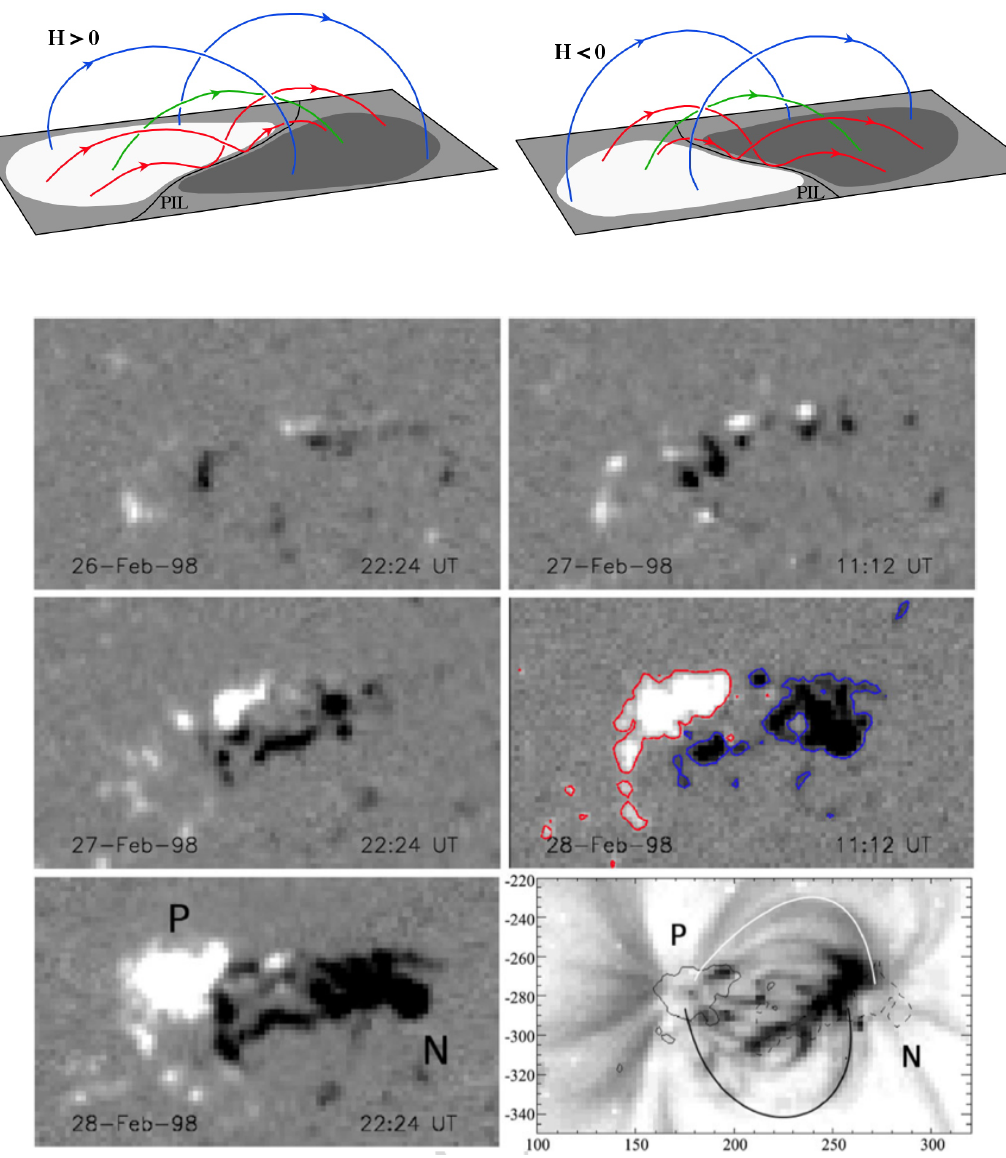
Figure 9: Upper panels: Sketches of magnetic “tongue” patterns in longitudinal magnetograms with (left) positive and (right) negative global twist in the emerging flux rope, which develop due to the presence of the transverse magnetic field component. Representative field lines of the enveloping arcade and internal (dipped) field lines are also shown. Middle and lower panels: Observations of evolving magnetic tongue pattern: SOHO/MDI magnetograms showing the emergence of AR 8171 between 26 – 28 February 1998. The magnetic tongue pattern indicates positive (right-handed) magnetic helicity (cf. upper left panel). Coronal loops seen in the SOHO/EIT image (taken on 1 March 1998; lowest right panel) indicates also positive shear/helicity in the corona. Image reproduced with permission from Luoni et al. (2011), copyright by